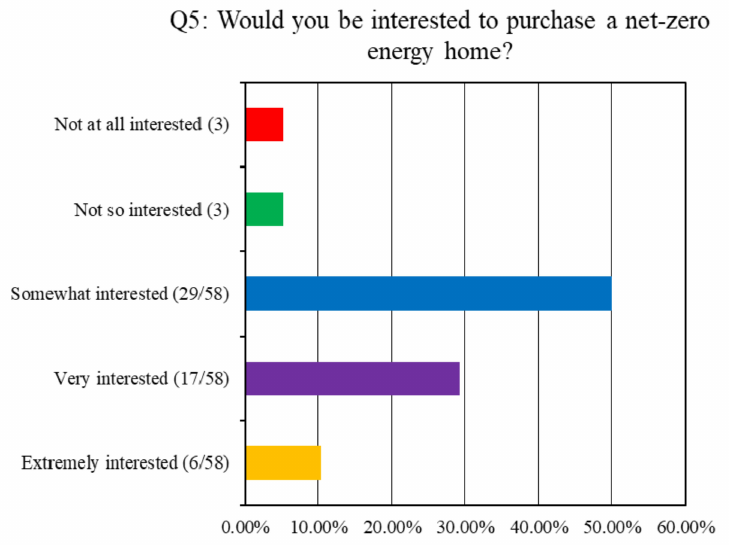
Figure 6. Participants’ interest in NZE homes (degree of purchase